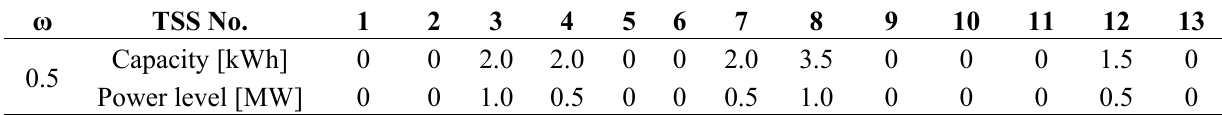
Table 6. Optimized schemes of high traffic